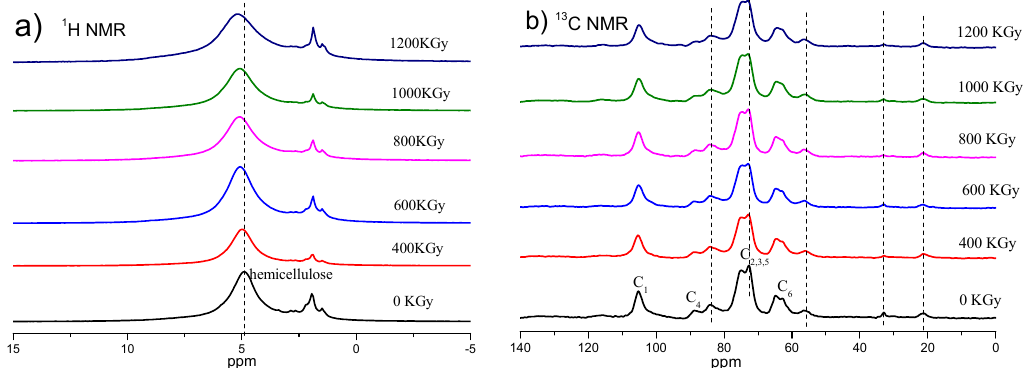
Figure 5. 1 H NMR ( a ) and 13 C NMR ( b ) profiles of Miscanthus irradiated with different doses.